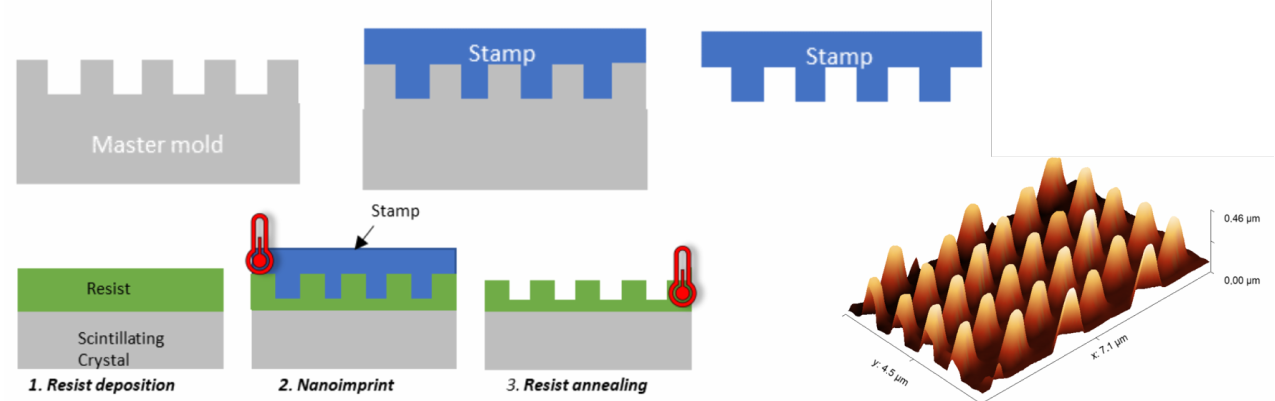
Figure 7. Simplified nanoimprinting process steps for pattern implementation ( left ) (for details see text). Atomic Force Microscope (AFM) image of a small area of the implemented pattern ( right )